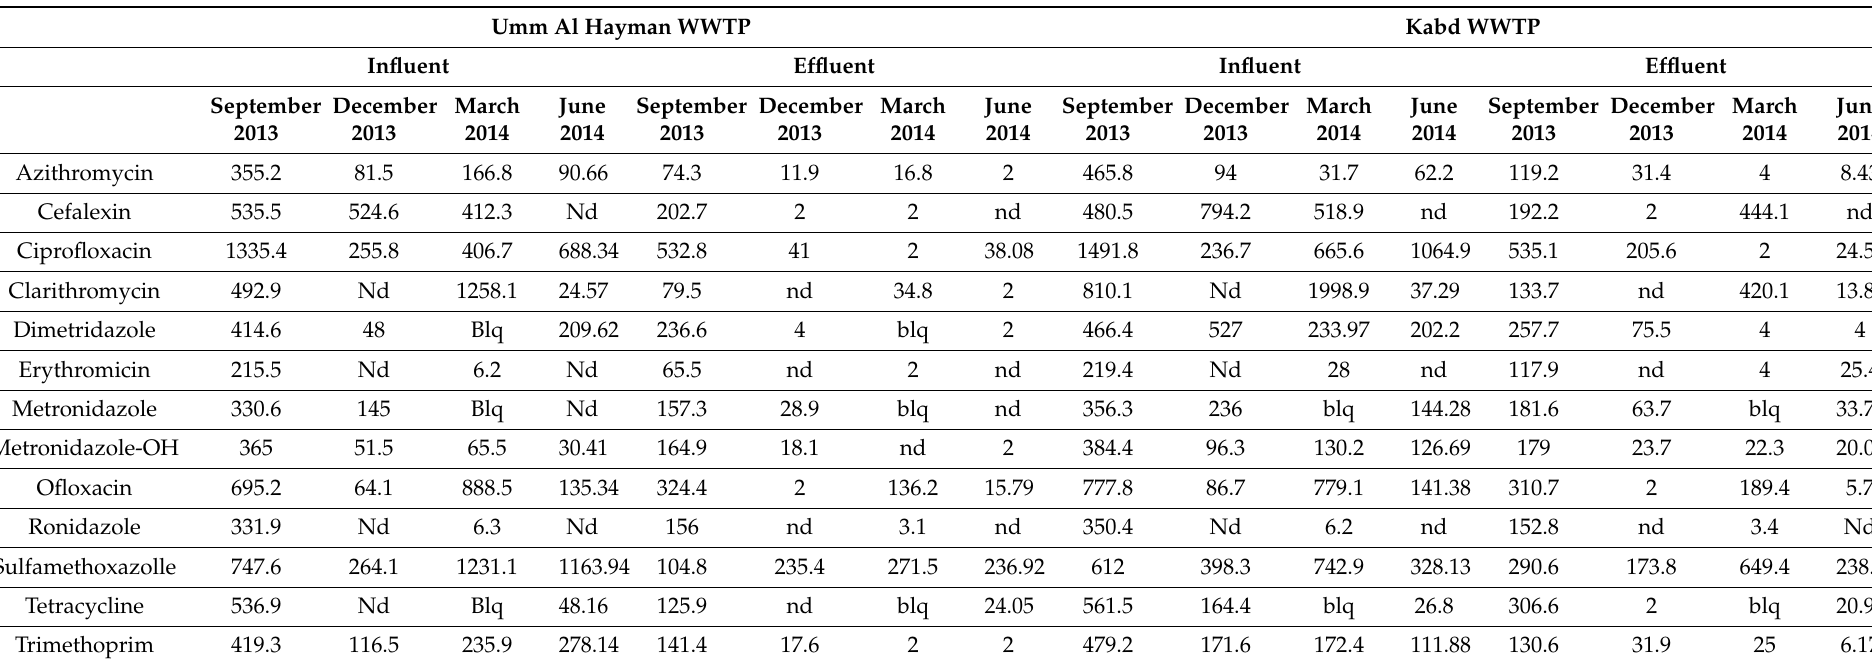
Table 6. Concentrations of antibiotics, expressed in ng/L, in influents and effluents of the two wastewater treatment plants in Kuwait, sampled at four different seasons of the